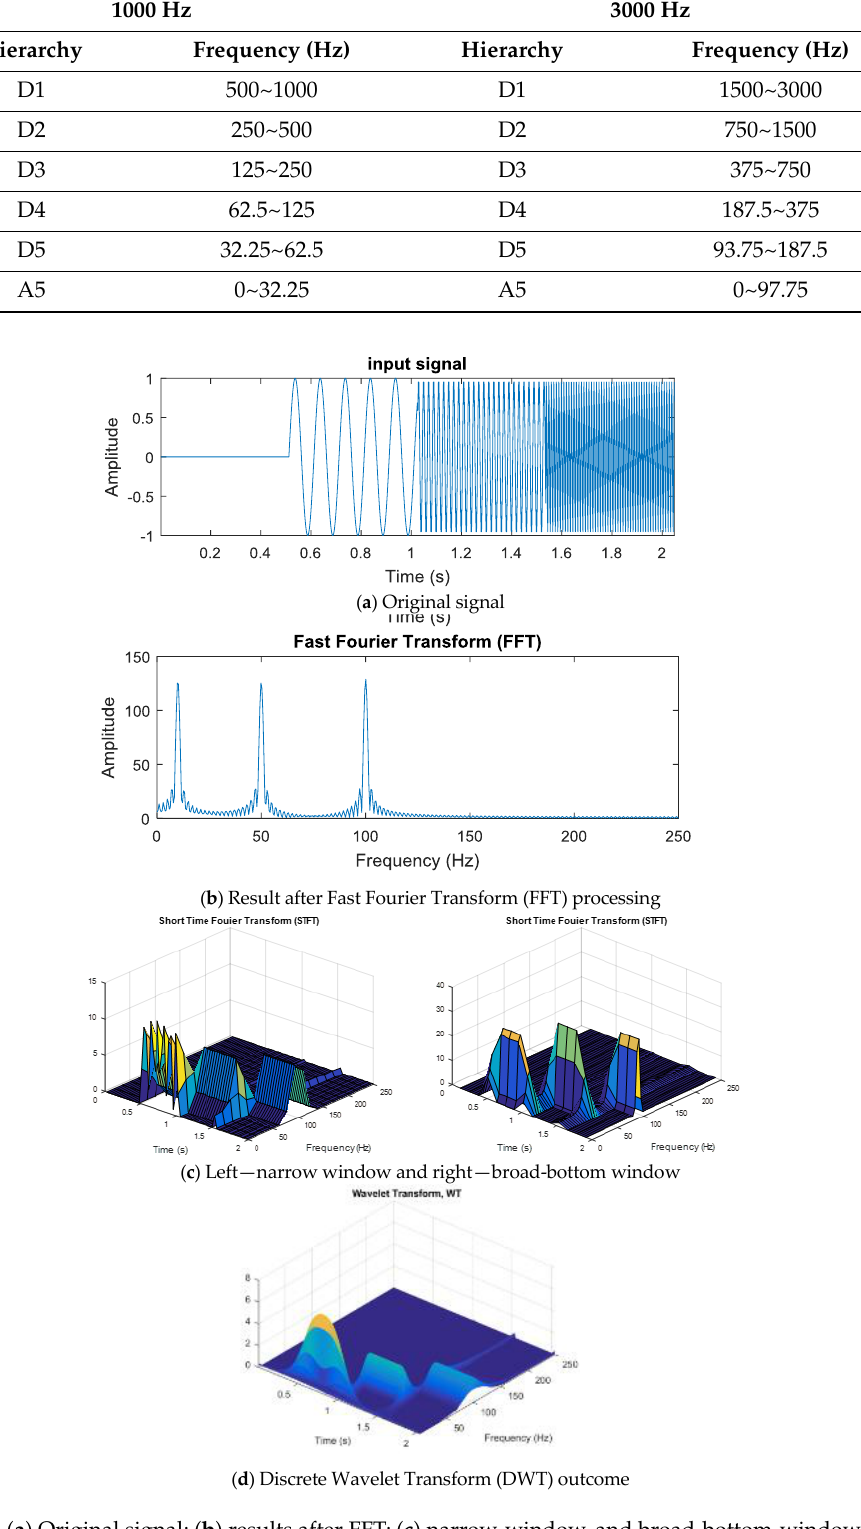
Figure 5. ( a ) Original signal; ( b ) results after FFT; ( c ) narrow-window, and broad-bottom-window; and ( d ) DWT outcome.